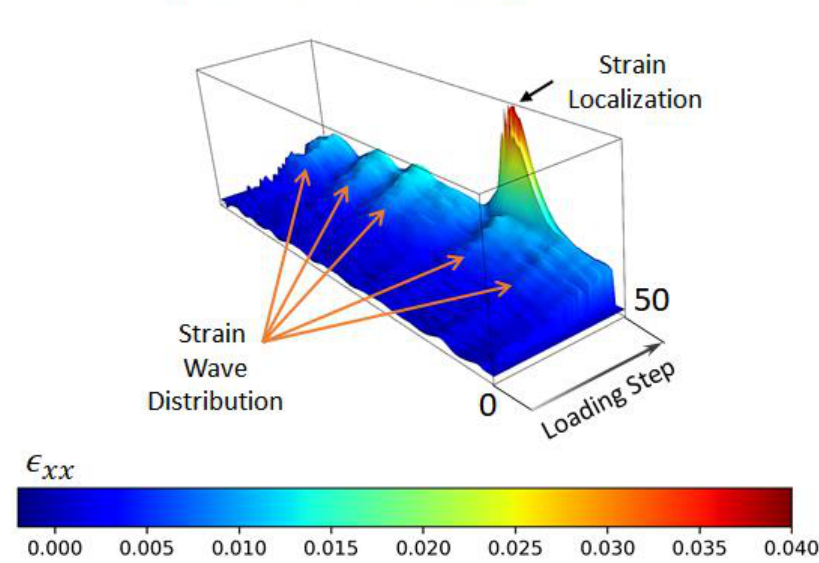
Figure 13. 3D DIC result representation with indicated strain wave-like distribution behaviour.